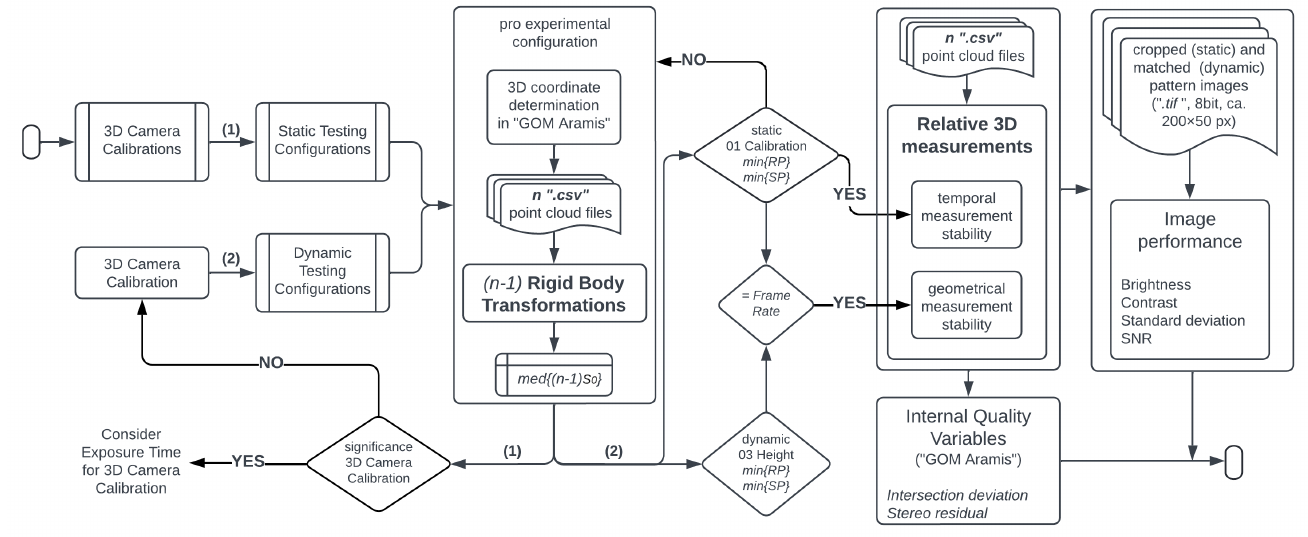
Figure 5. Workflow for the evaluation of the accuracy potential of high frequency measurements.